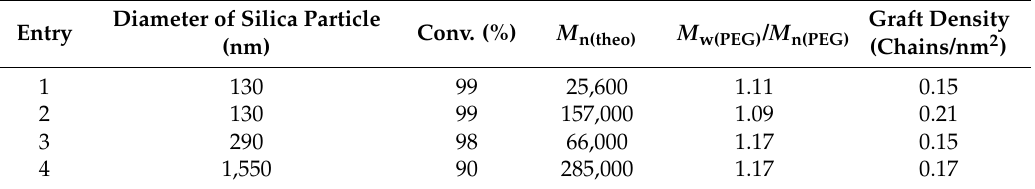
Table 2. Characters of silica particles grafted with concentrated poly(DEMM-TFSI) brush.